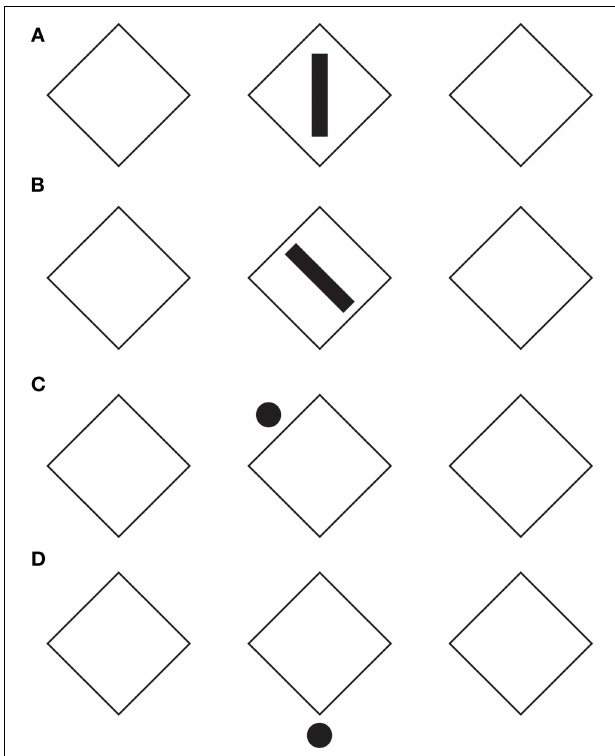
FIGURE 7 | The directional organization influences nearby figures. For further details please see the